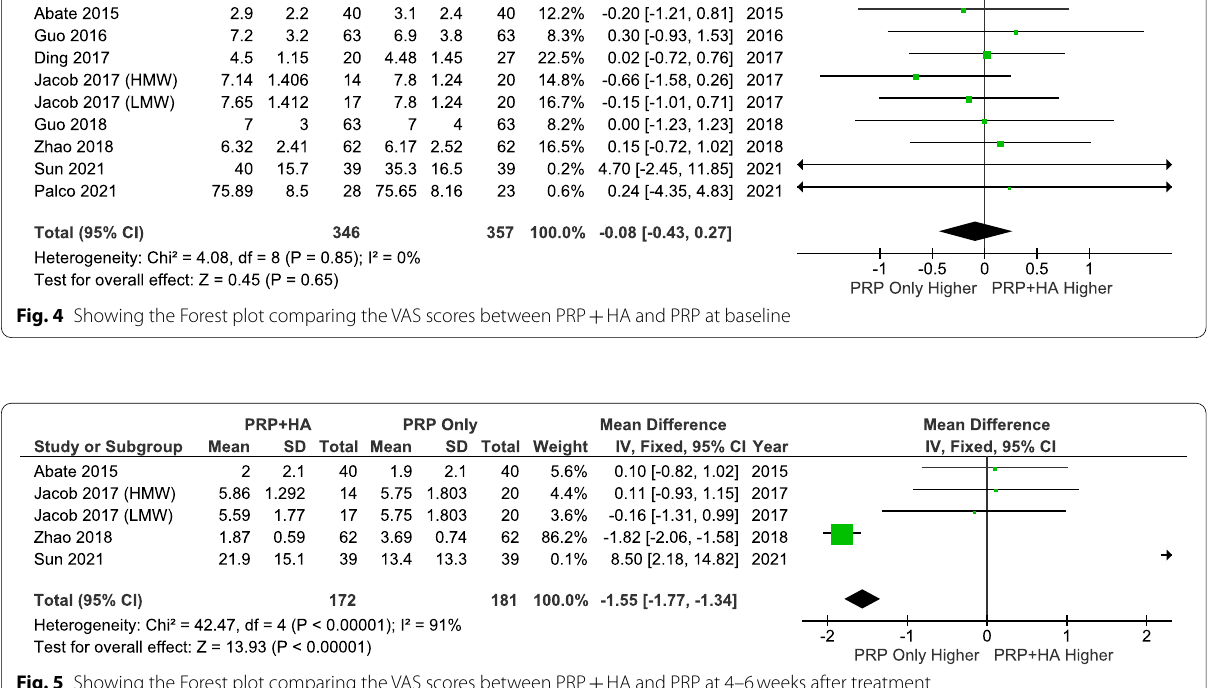
7.18 to 1.00, P 0.010 < 0.05) − − =